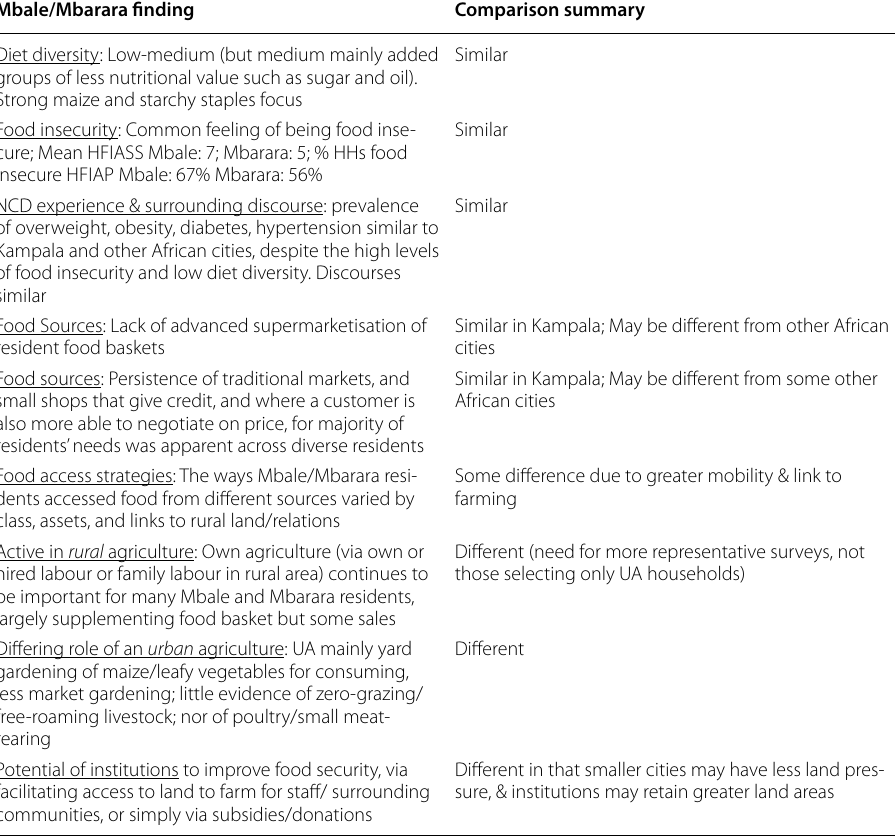
Table 3 Conclusions from Comparative Analysis with Kampala and other African Primary Cities Mbale/Mbarara finding Comparison